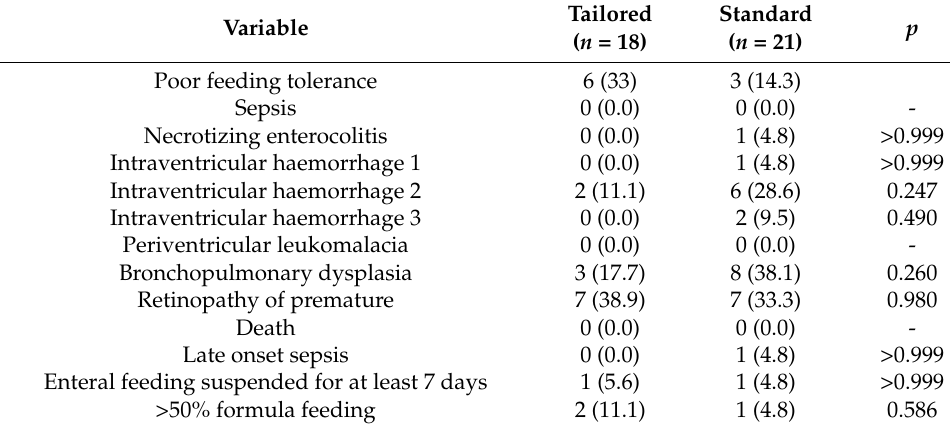
Table 4. Secondary